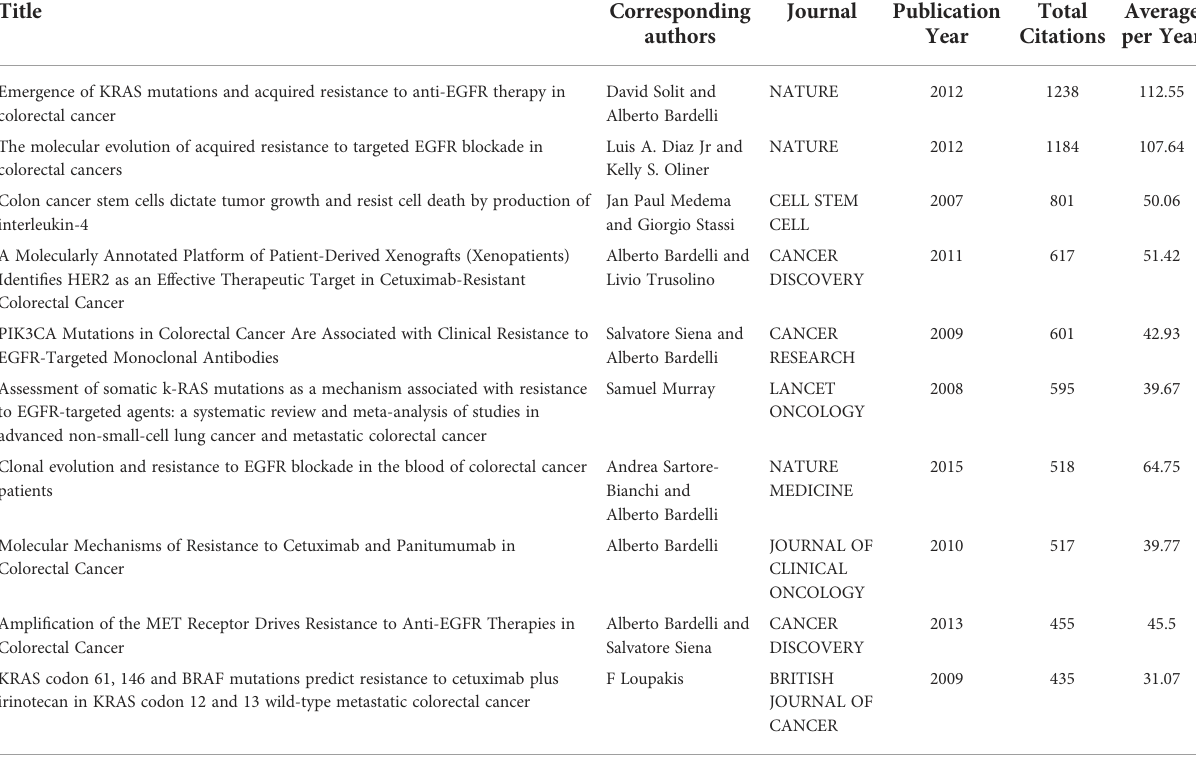
TABLE 4 Top 10 high-cited papers related to drug resistance in colorectal